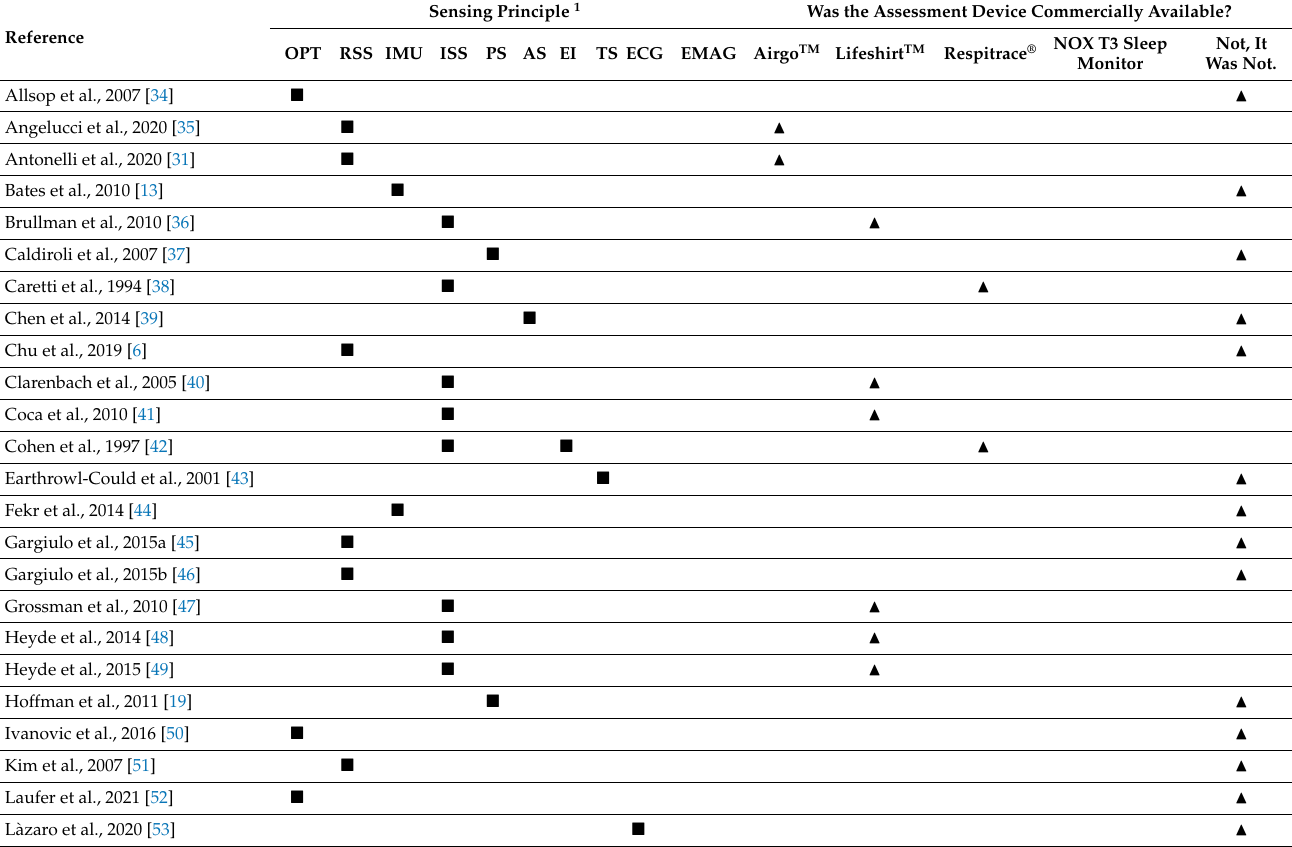
Table 2. Main sensing